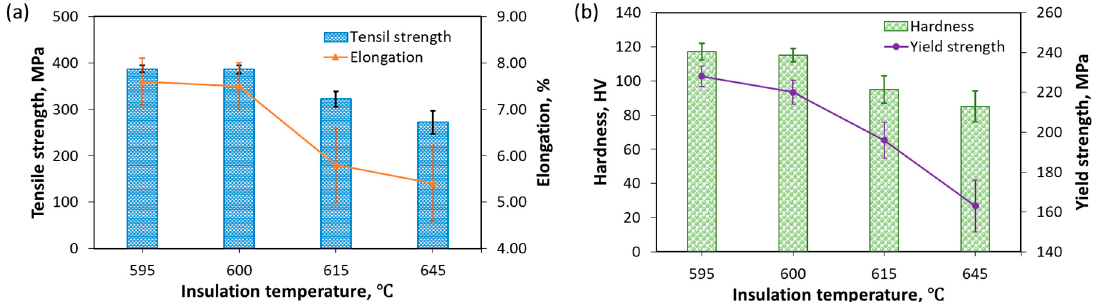
Figure 7. Effects of insulation temperature on the mechanical property of scrolls: ( a ) tensile strength and elongation; ( b ) yield strength and hardness.